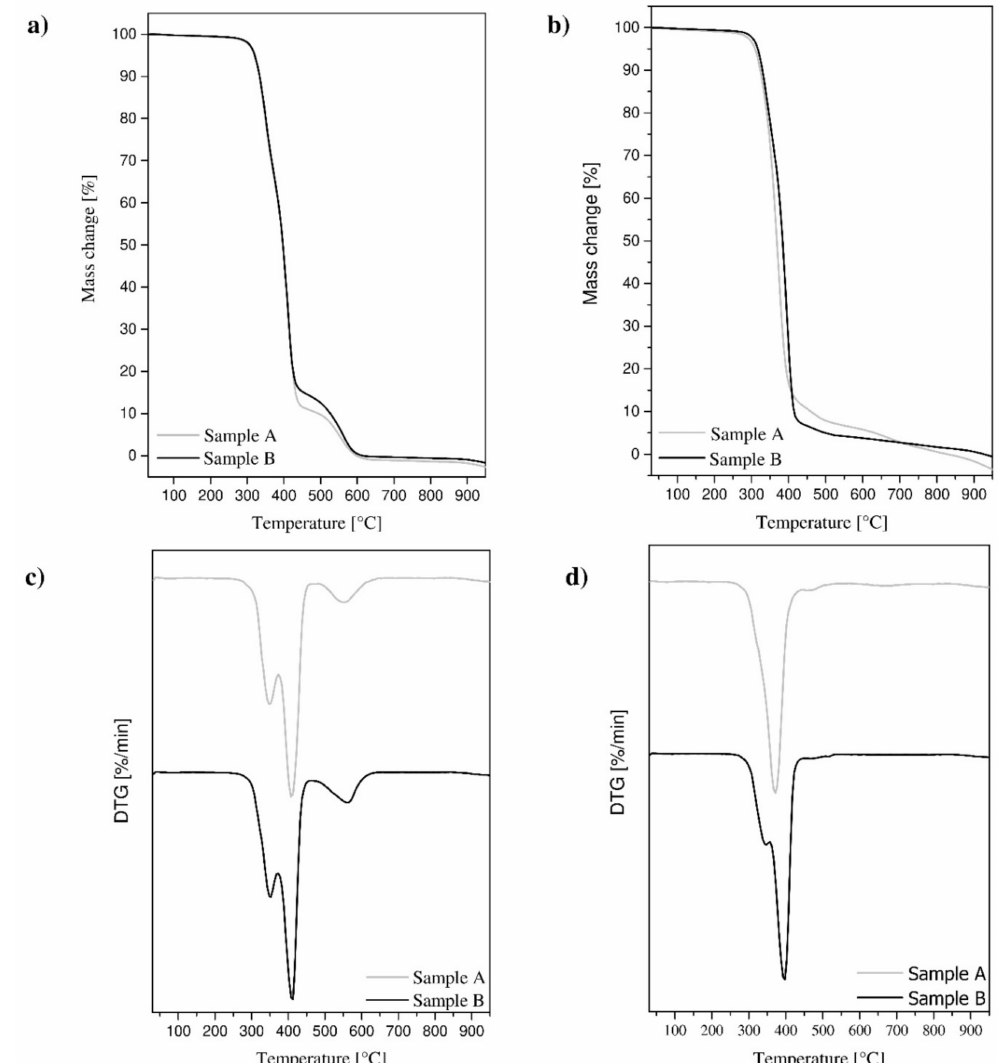
Figure 4. Thermogravimetric curves made in the atmosphere of a flowing gas: air ( a ) and nitrogen ( b ) and derivatographic curves in the atmosphere of a flowing gas: air ( c ) and nitrogen ( d